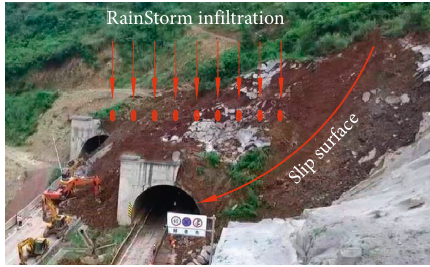
Figure 20: Overall instability failure case of a tunnel portal in